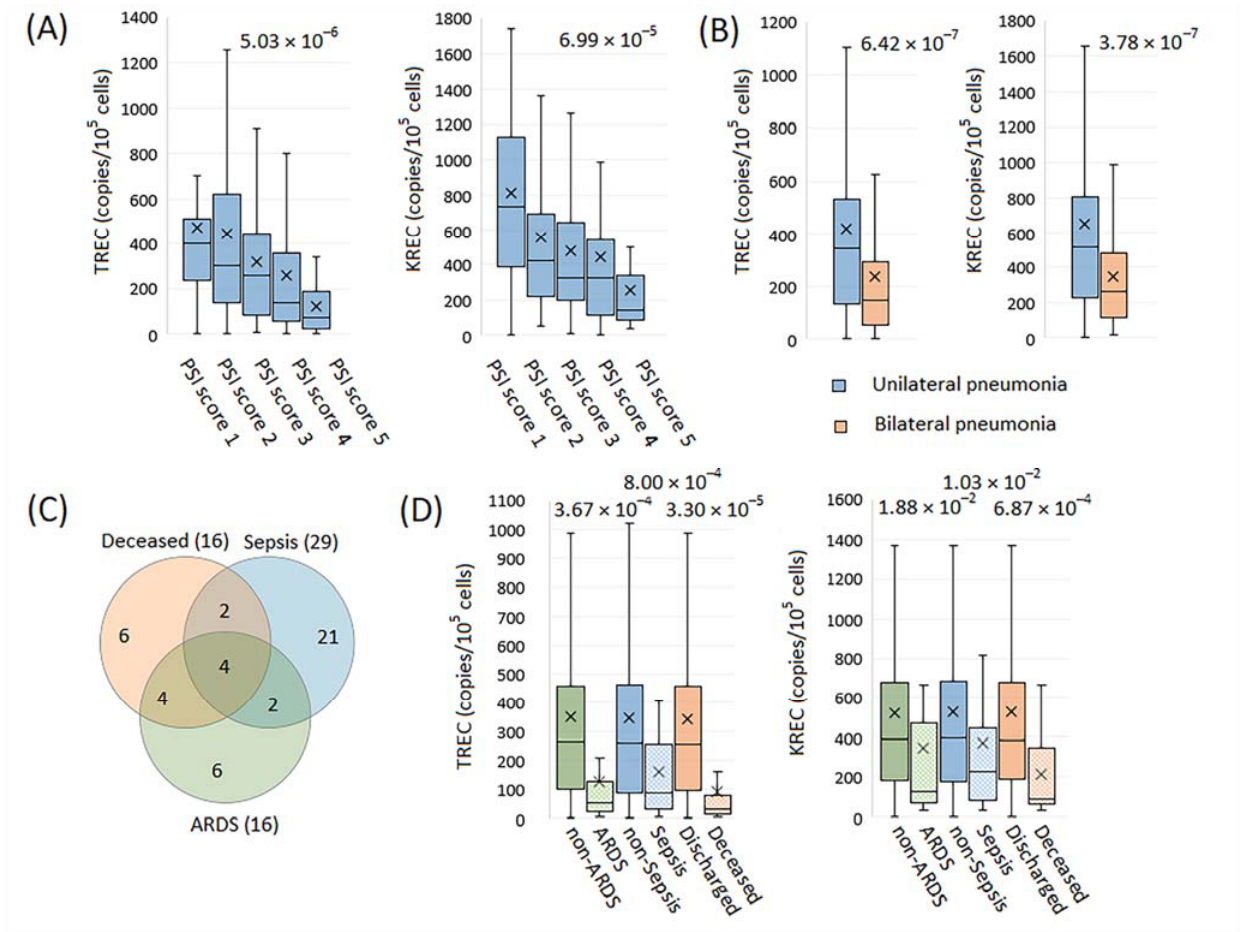
Figure 5. TREC/KREC counts related to pneumonia severity and outcome. Community-acquired and nosocomial pneumonia are considered together. Box-plots depicting differences between TREC/KREC levels in patients ( A ) with different Pneumonia Severity Index (PSI) and ( B ) with bilateral compared to unilateral pneumonia. ( C ) Venn diagram of acute respiratory distress syndrome (ARDS), sepsis and lethal outcome in patients with pneumonia. ( D ) Box-plots for TREC/KREC levels in patients with ARDS, sepsis and lethal outcome versus patients without ARDS, sepsis and lethal outcome (discharged). ( C , D ) The sepsis group included patients with sepsis and septic shock.